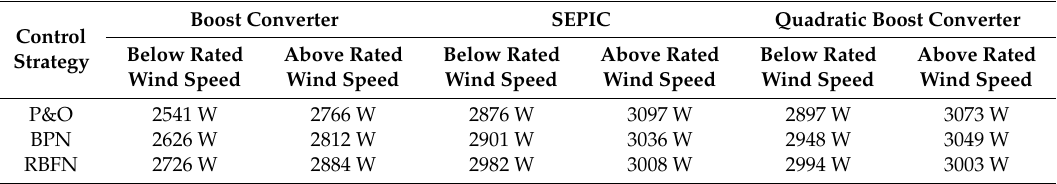
Figure 14. Experimental results output for RBFN based Quadratic boost converter, ( a ) output voltage; ( b ) output current; and ( c ) output power. Table 3. Comparison of maximum power obtained using boost, sepic and quadratic boost converters for different control strategies.